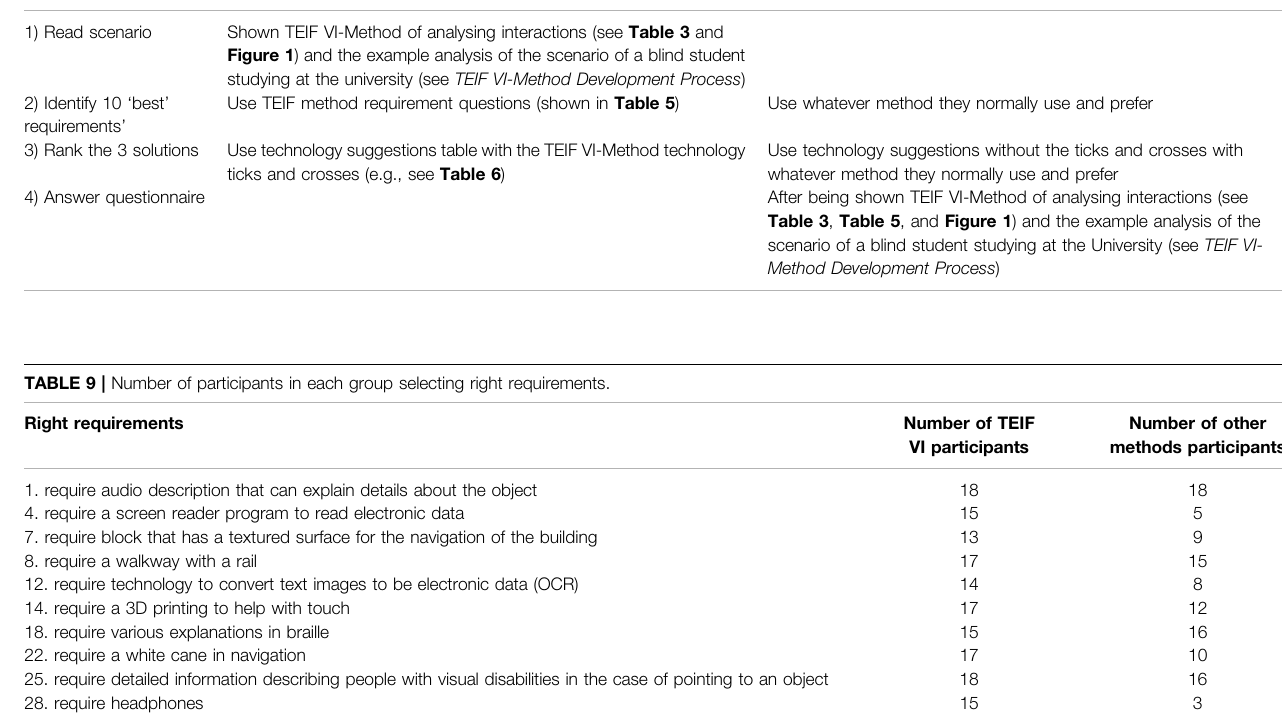
TABLE 8 | Experimental tasks and information provided to the two groups. Experiment tasks